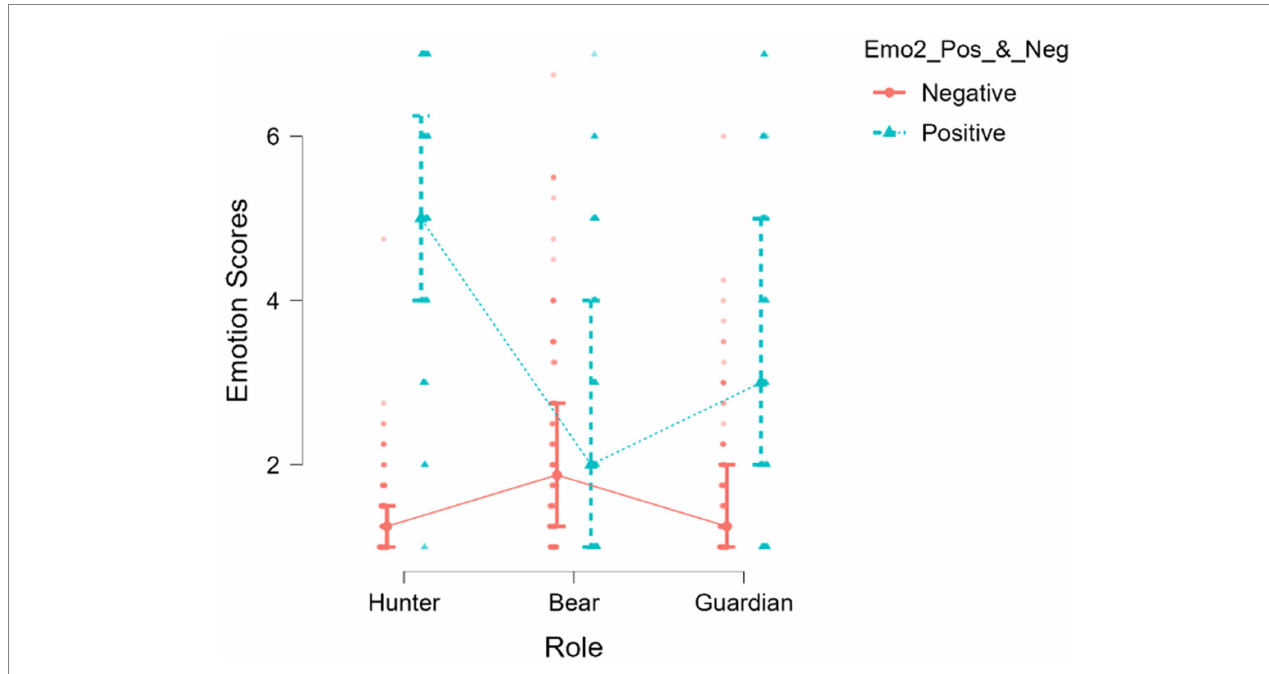
FIGURE 2 Units of emotional meaning in the Bear role.